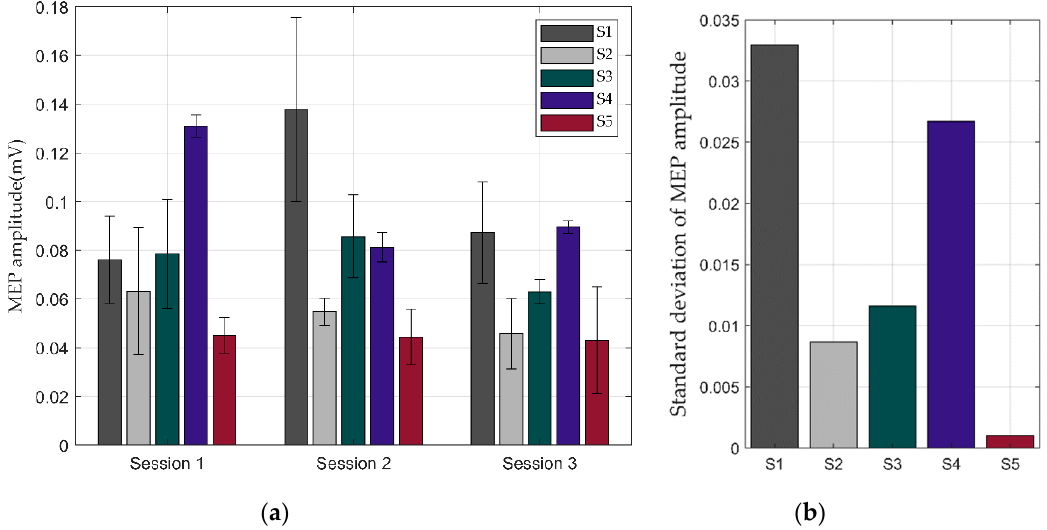
Figure 11. Result of repeated response experiments thorough stimulation of motor cortex using the